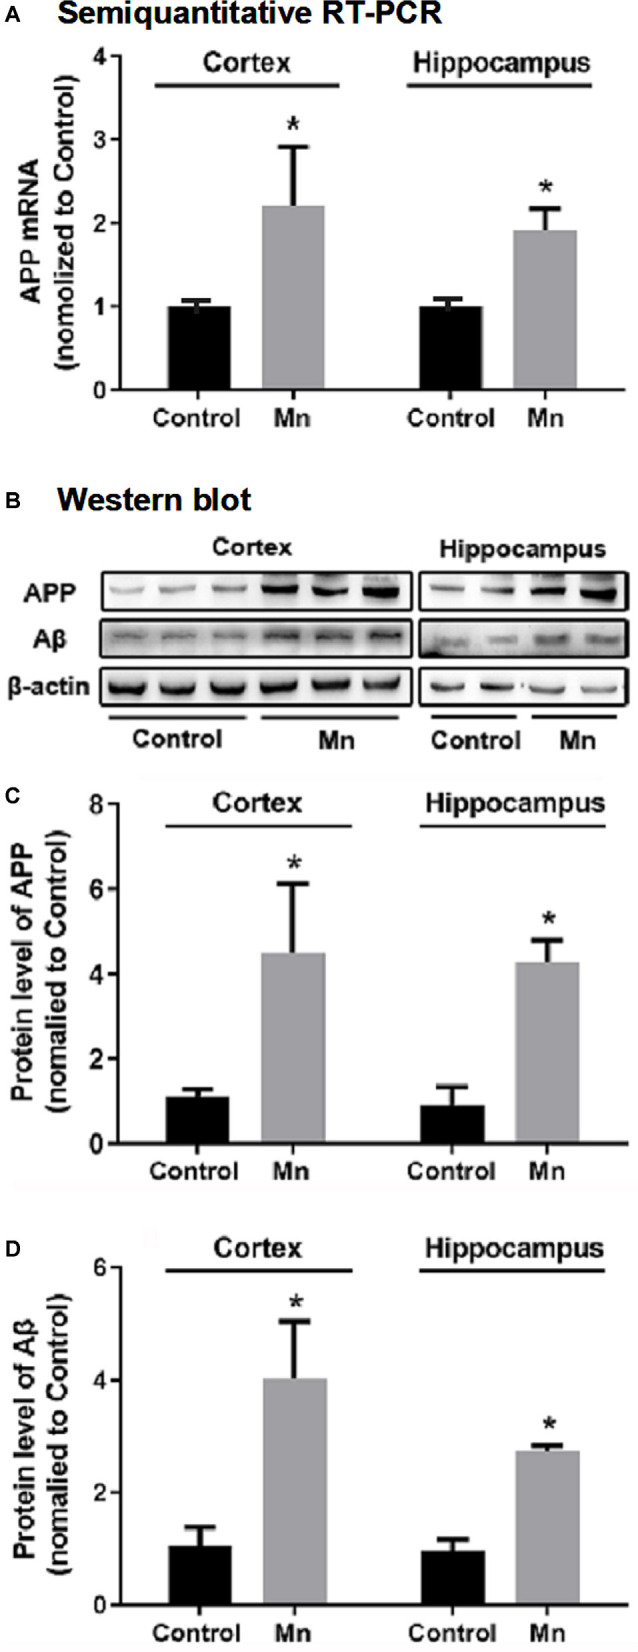
Chronic Mn treatment increased β-amyloid (Aβ) production in 3×Tg-AD mouse brains. (A) APP mRNA level in 3×Tg-AD mouse brains, determined by semiquantitative RT-PCR with GAPDH mRNA serving as the internal control, was increased in the cerebral cortex and hippocampus of Mn-treated 3×Tg-AD mice. (B–D) The protein expression of APP and Aβ in 3×Tg-AD mouse brain, determined by Western blot, was increased in the cortex and hippocampus of Mn-treated 3×Tg-Ad mice. β-actin was used as the internal control. n = 5 mice for each group. *p < 0.05, compared with the control group, t-test.